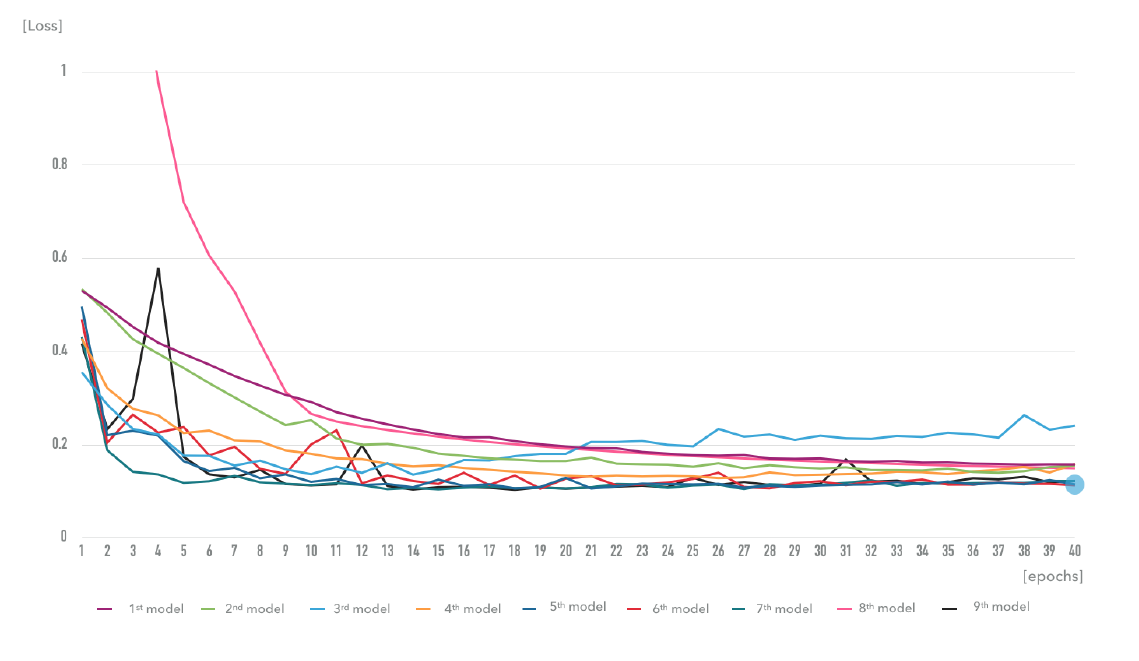
Figure 7. Validation loss during training for 40